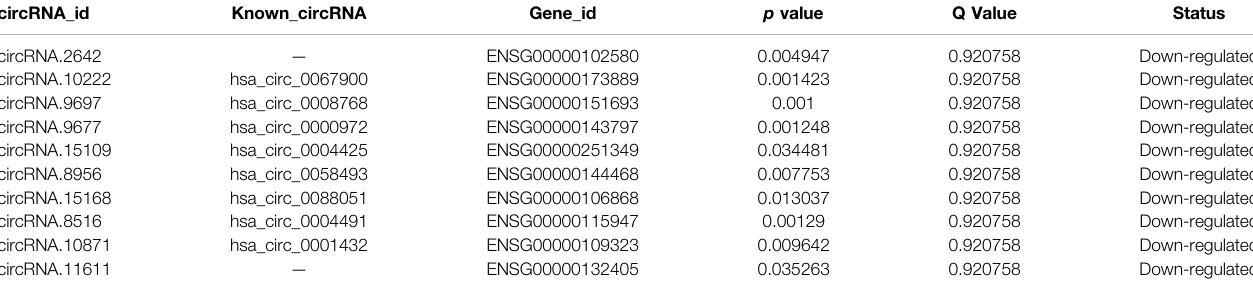
TABLE 4 | Top 10 signi fi cantly downregulated circRNA between